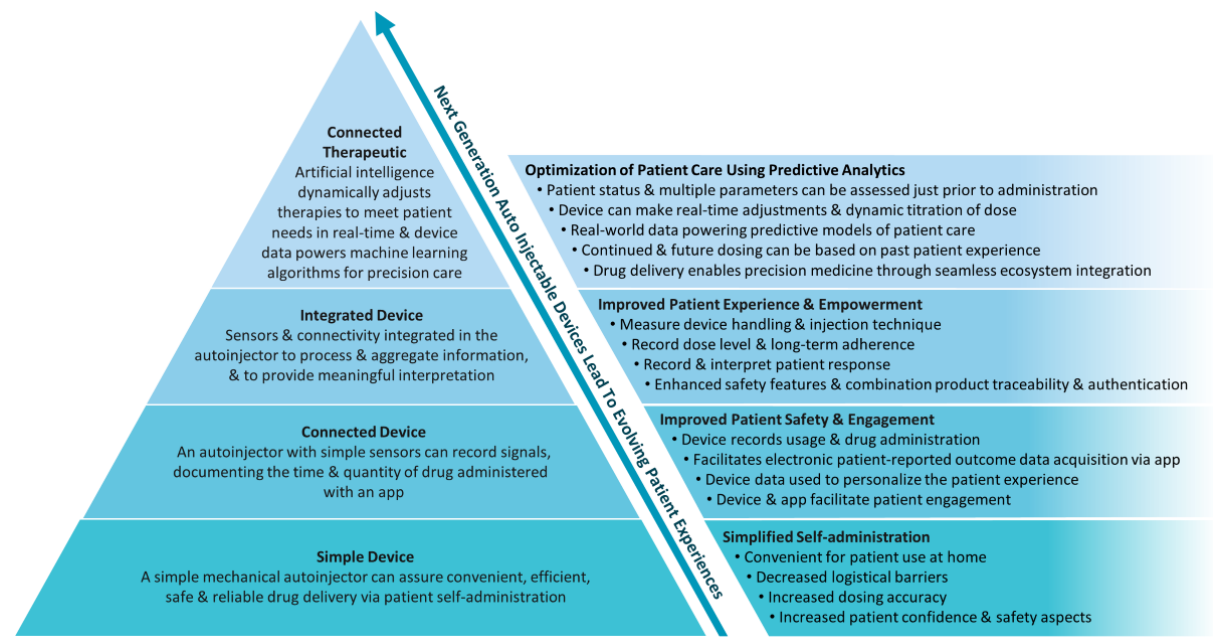
Figure 4. Framework for next-generation connected autoinjectable devices. This framework for next-generation connected autoinjectors demonstrates the technological hierarchy of design (left) that transitions the simple device to a connected therapeutic. Through this design evolution, the autoinjector shifts to become the focal point of decentralized precision care for many chronic conditions, powering artificial intelligence disease management systems that impact overall patient care